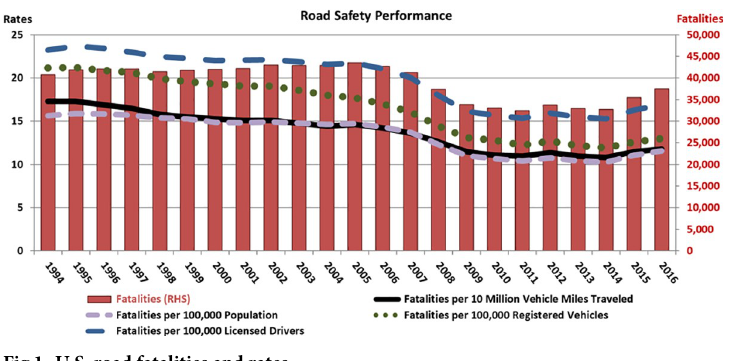
Fig 1. U.S. road fatalities and